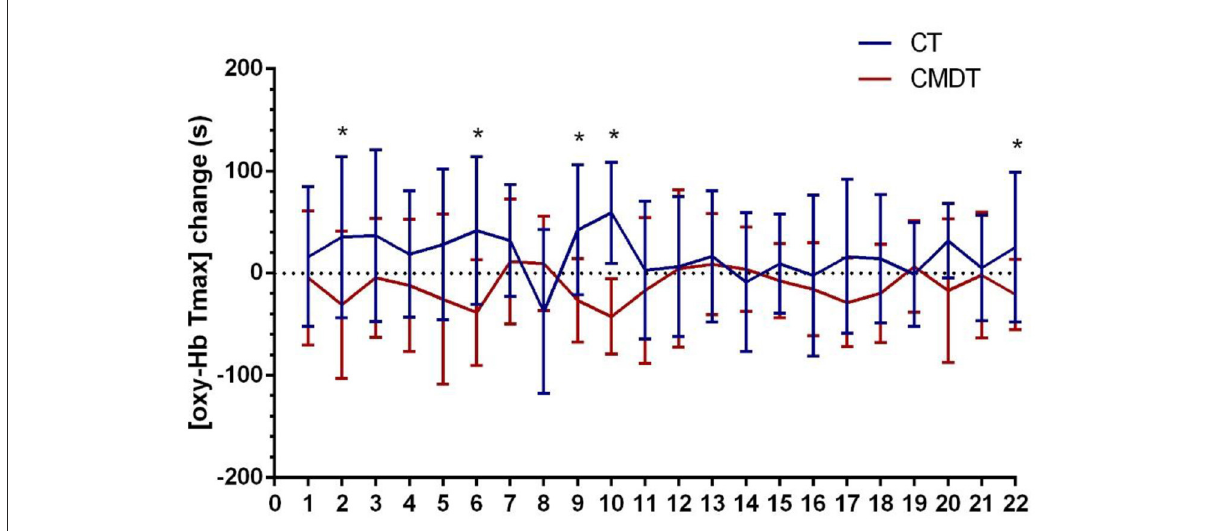
FIGURE6 Changes in [oxy-Hb Tmax] across 22 channels. Error bars represent one standard error of the mean. *Statistical